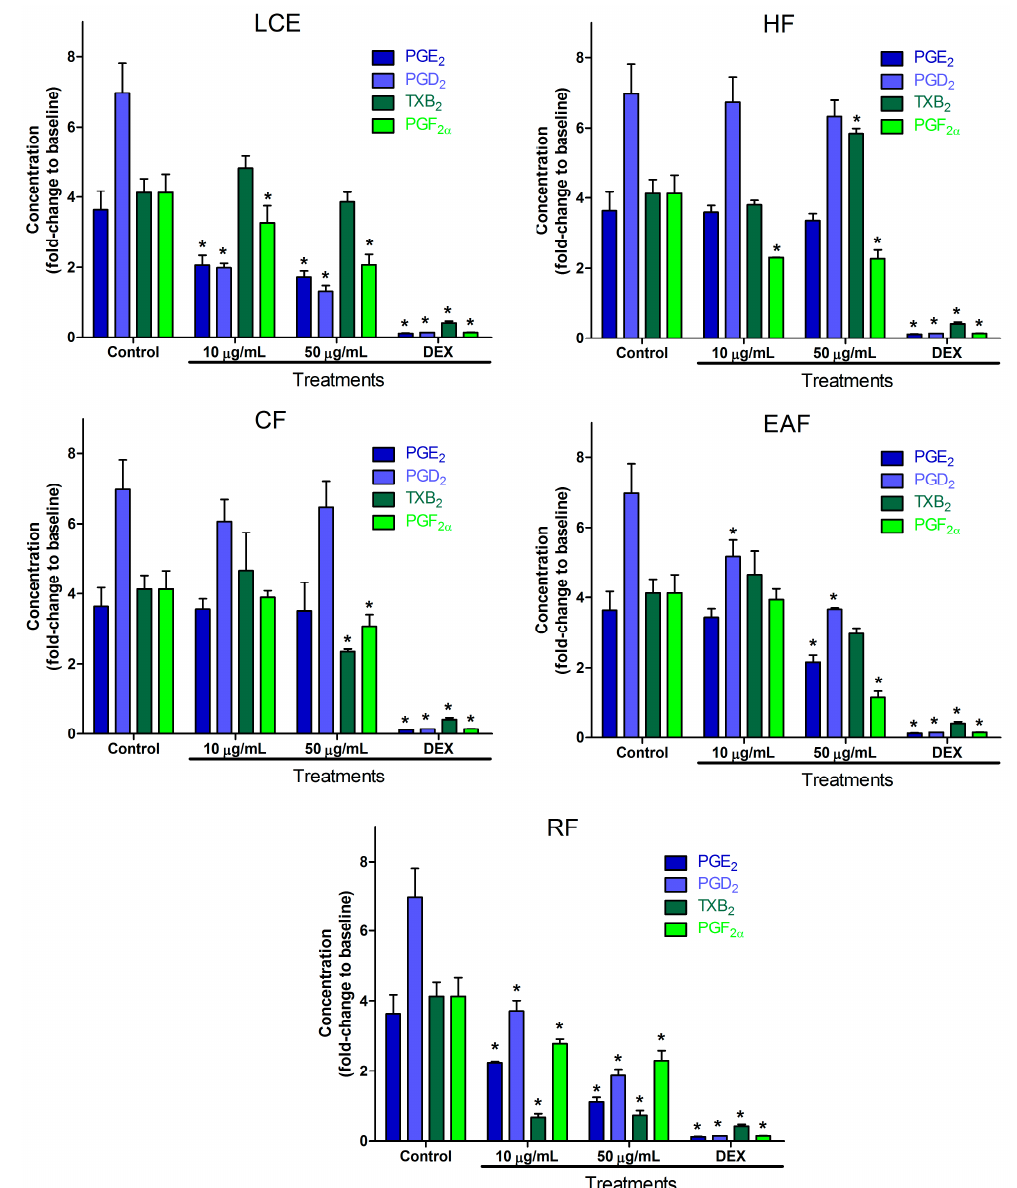
Figure 2. Effect of leaf crude extract, hexane fraction, chloroform fraction, ethyl acetate fraction, and residual fraction of S. cordifolia on PGE 2 , PGD 2 , TXB 2 , and PGF 2 α production in LPS-stimulated RAW 264.7 cells. Cells were treated with LPS in the absence or presence of the fractions at two concentrations (10 and 50 µ g/mL). DEX was used as positive control. After incubation, cell culture supernatants were harvested, and PGE 2 , PGD 2 , TXB 2 , and PGF 2 α production was determined. Values are expressed as mean ± SD. * p < 0.001 vs. control (LPS alone).